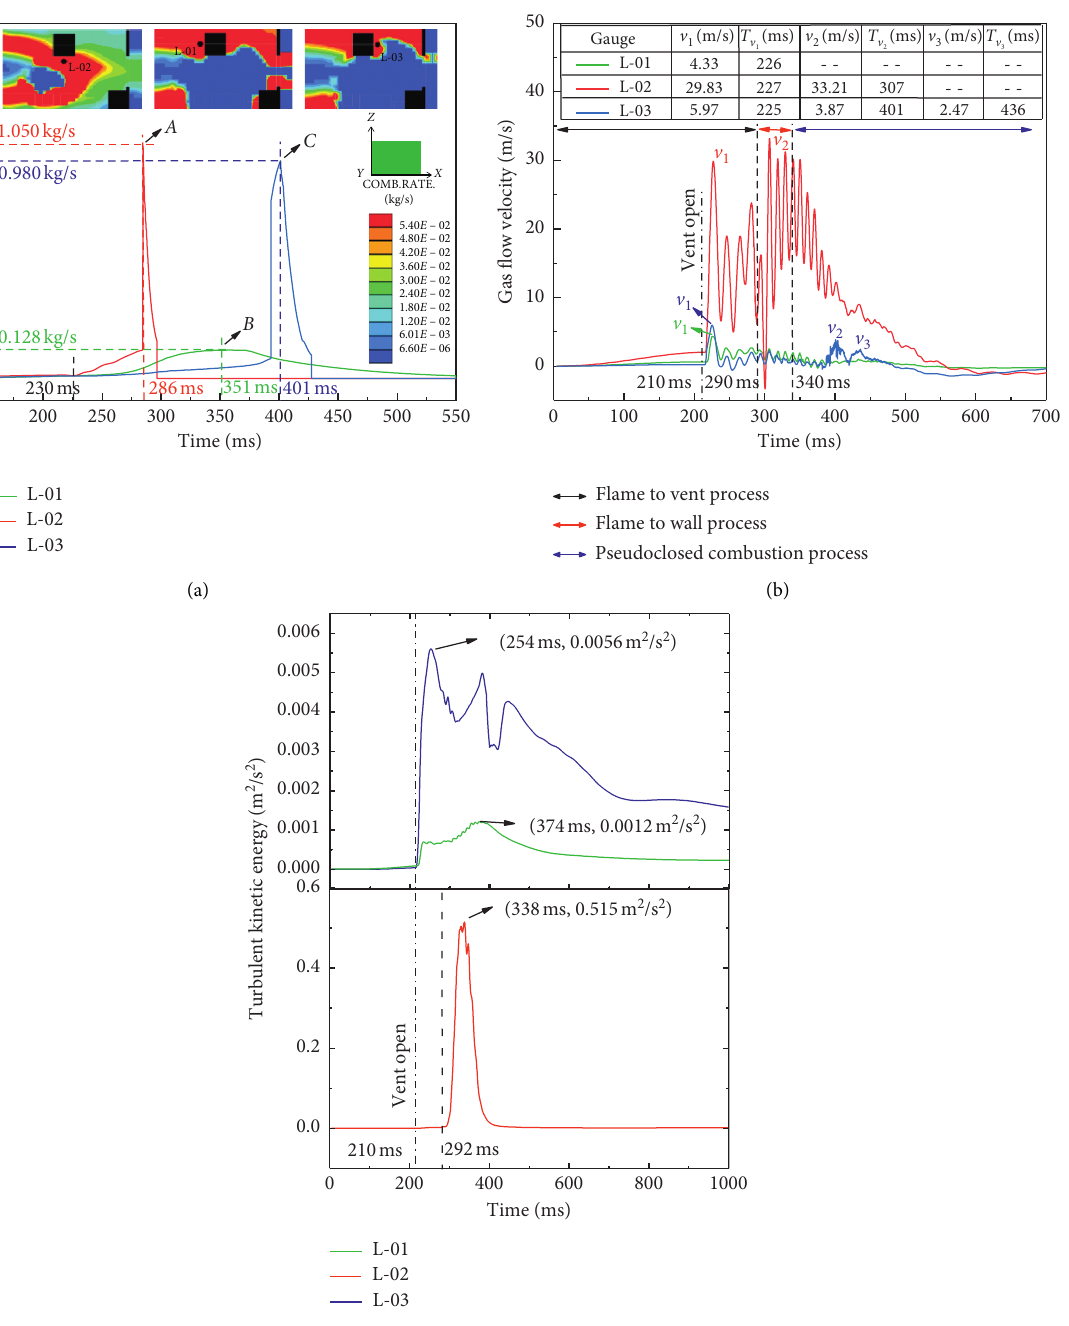
Figure 12: Time curve of flow-field parameter change in the vicinity of refrigerator. (a) Combustion rate. (b) Gas flow velocity. (c) Turbulent kinetic